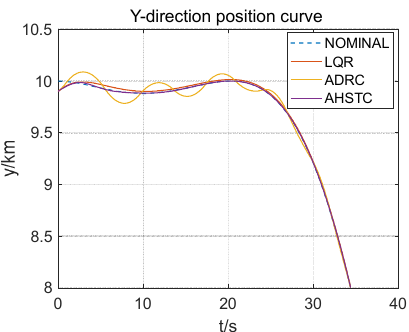
Figure 13. Height y tracking curve.